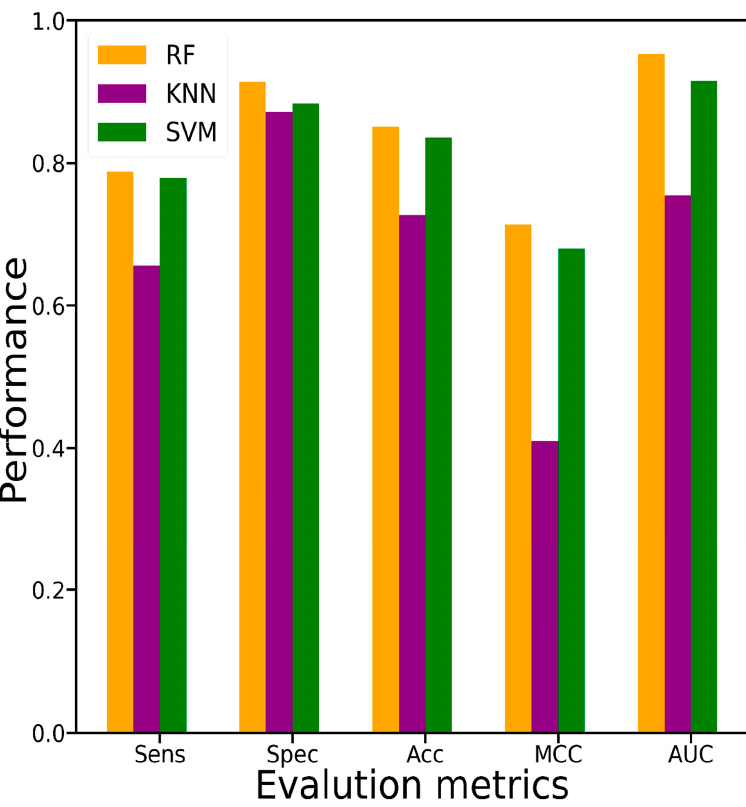
Figure 4. Performance comparison among three different machine learning (ML) methods of RF, SVM and KNN.